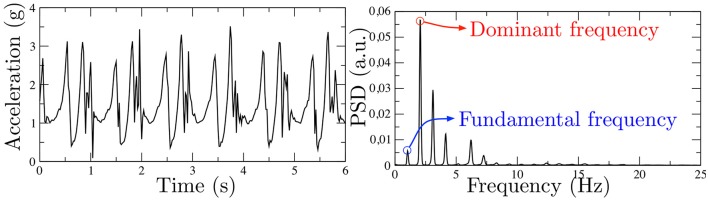
Real gait acceleration signal in time domain (Left) and frequency domain (Right), where a clear harmonic structure can be observed.